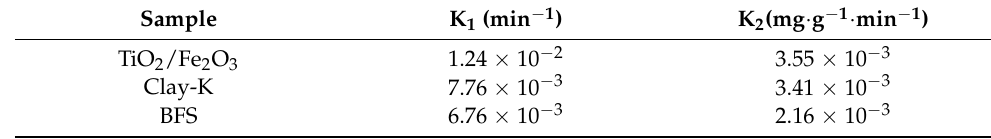
Figure 8. Modeling of cyanide adsorption kinetics in TiO 2 /Fe 2 O 3 , Clay-K, and BFS samples. ( a ) Pseudo first order and ( b ) Pseudo second order model. Table 2. Adsorption kinetics constants of pseudo second order model and R square constant.